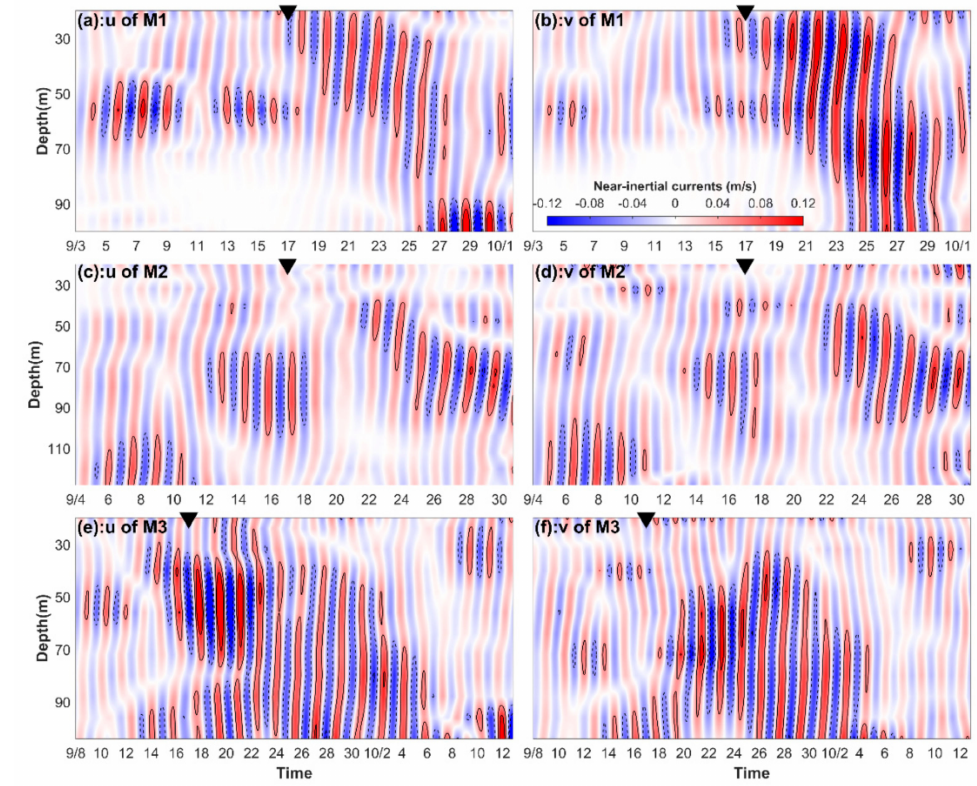
Figure 5. Evolution of zonal and meridional near-inertial currents obtained by a band-pass filter in M1, M2, and M3. The dashed contours are –0.05 and –0.10 m/s, and the solid contours are 0.05 and 0.10 m/s. The triangles denote the passage of typhoon